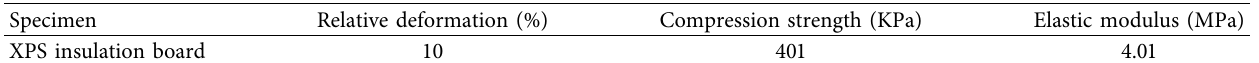
Table 2: Experimental results of compression performance of